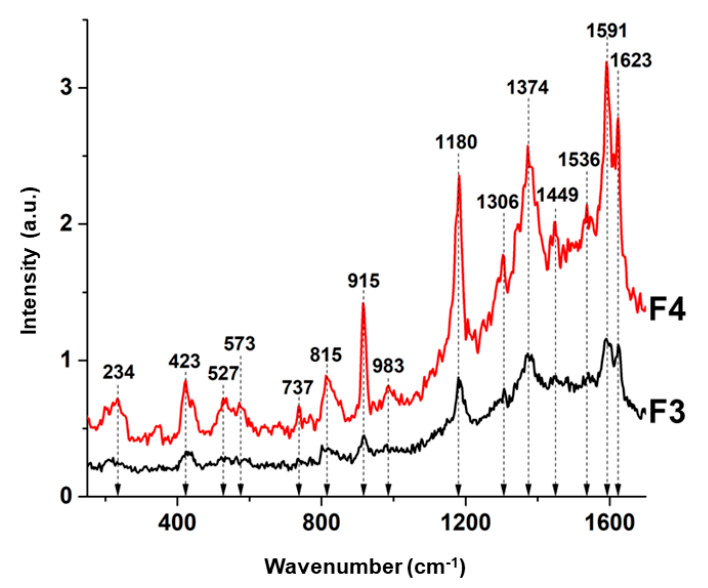
Figure 18. SERS spectra of 10 − 4 M crystal violet placed on supports F3 and F4.